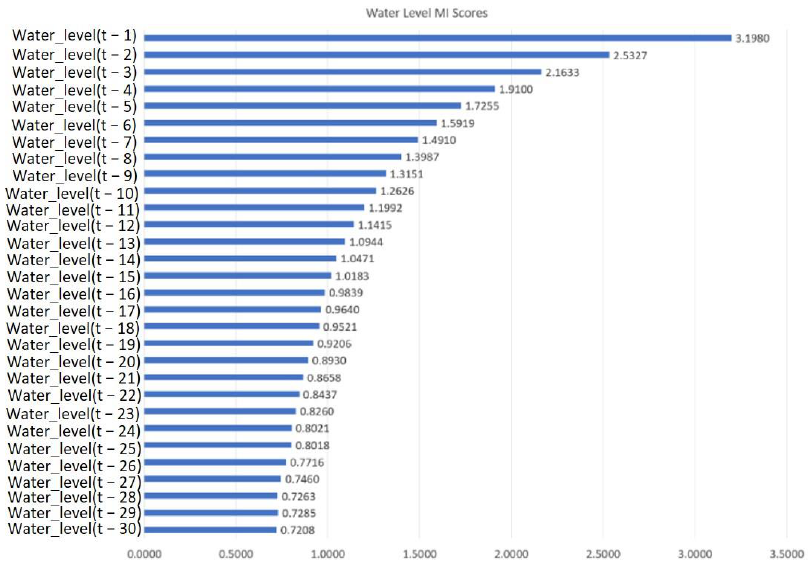
Figure 5. Autocorrelation of daily water levels in the Feitsui Reservoir.